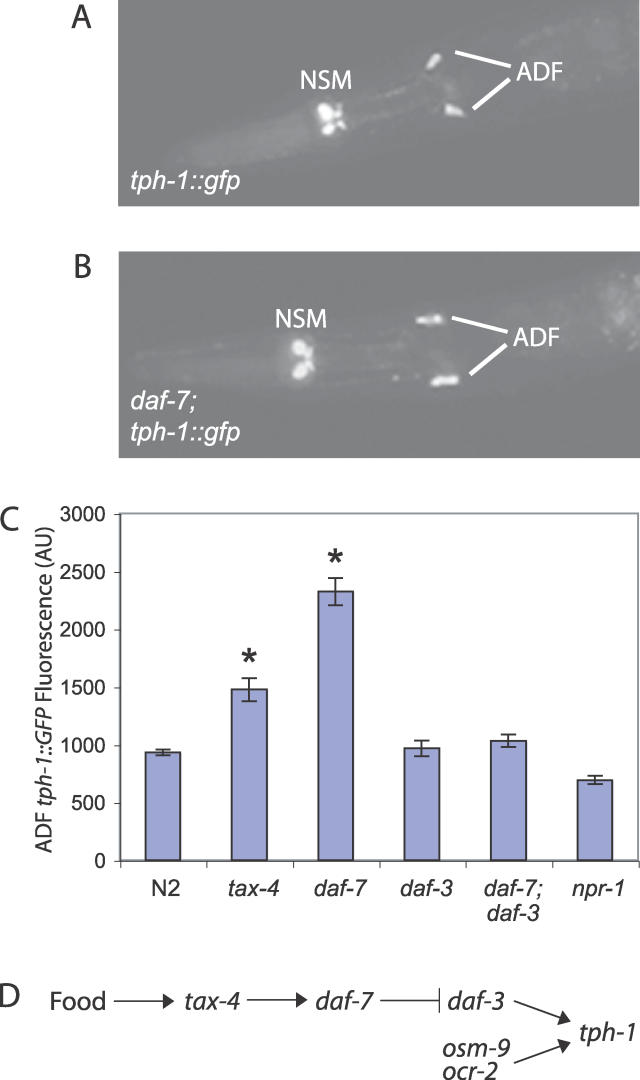
Serotonin Production in ADF Neurons is Regulated by TGF-β Signaling(A–B) tph-1::GFP expression in wild-type (A) and daf-7 (B) adults. Anterior is to the left. Two NSM neurons and two ADF neurons are visible in each animal.(C) Quantitation of tph-1::GFP fluorescence in ADF neurons. Asterisks, values different from N2 controls at p < 0.01 by Dunnett test. daf-7 mutants were different from N2, daf-3, and daf-7; daf-3 at p < 0.05 by Bonferroni t test. n ≥ 18 animals per genotype. Error bars denote SEM.(D) Model for food regulation of aerotaxis, combining genetic results from Figure 6 with molecular results from this Figure.